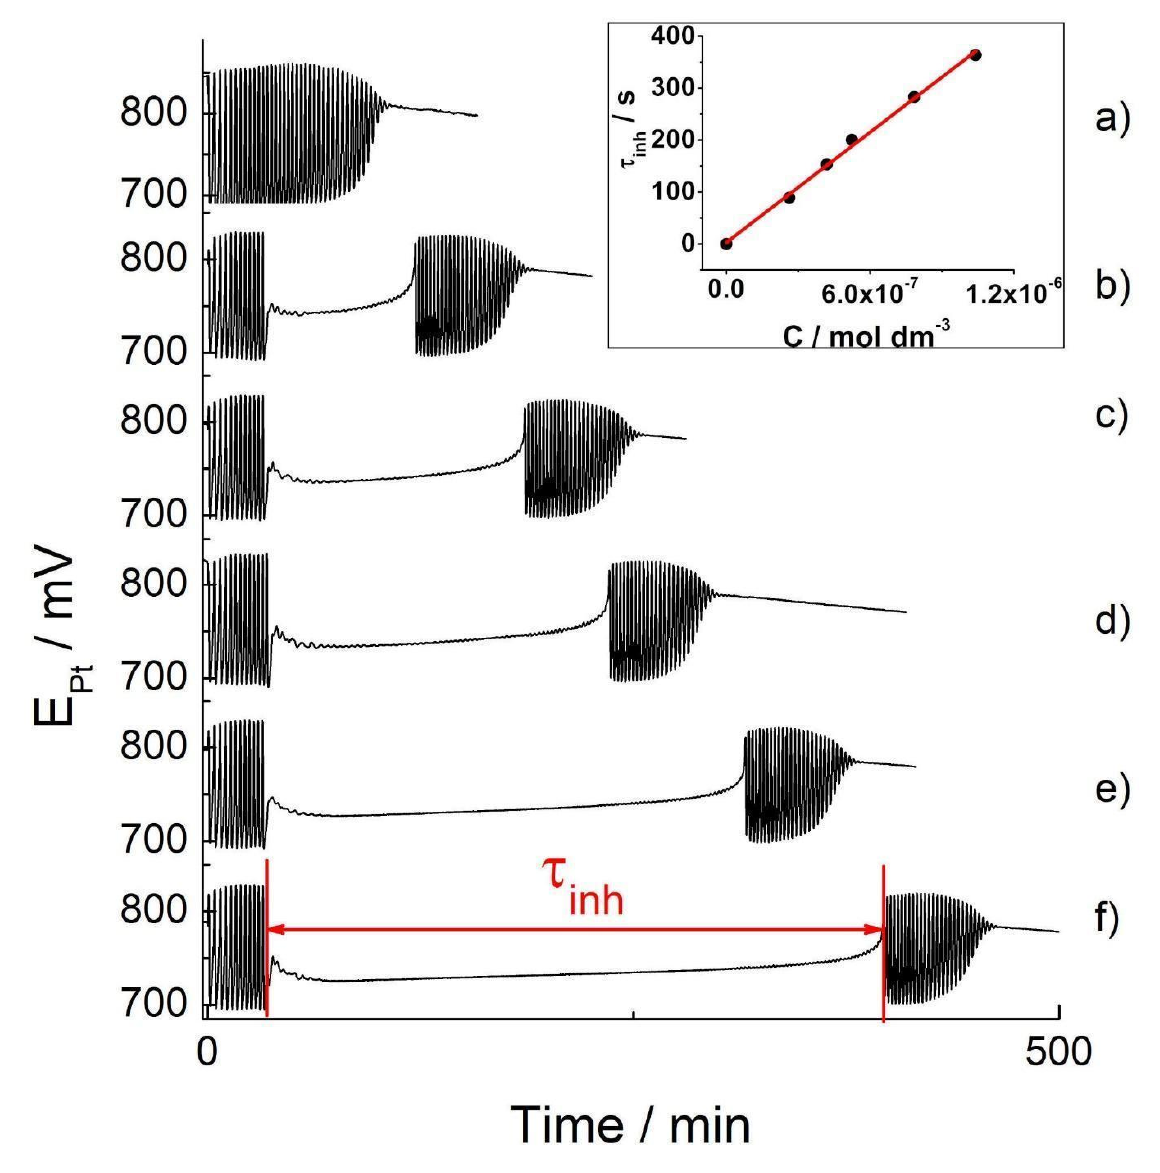
Figure 4. The Pt Electrode BR oscillograms: the basic BR oscillogram ( a ) and the oscillograms obtained by the addition of tested concentrations of the indigo carmine in food dye: 2.62 × 10 − 7 mol dm − 3 ( b ); 4.19 × 10 − 7 mol dm − 3 ( c ); 5.24 × 10 − 7 mol dm − 3 ( d ); 7.84 × 10 − 7 mol dm − 3 ( e ); 1.04 × 10 − 6 mol dm − 3 ( f ): inserted picture: the calibration curves obtained from the concentrations of indigo carmine of the food dye when added to the oscillating Briggs–Rauscher reaction.